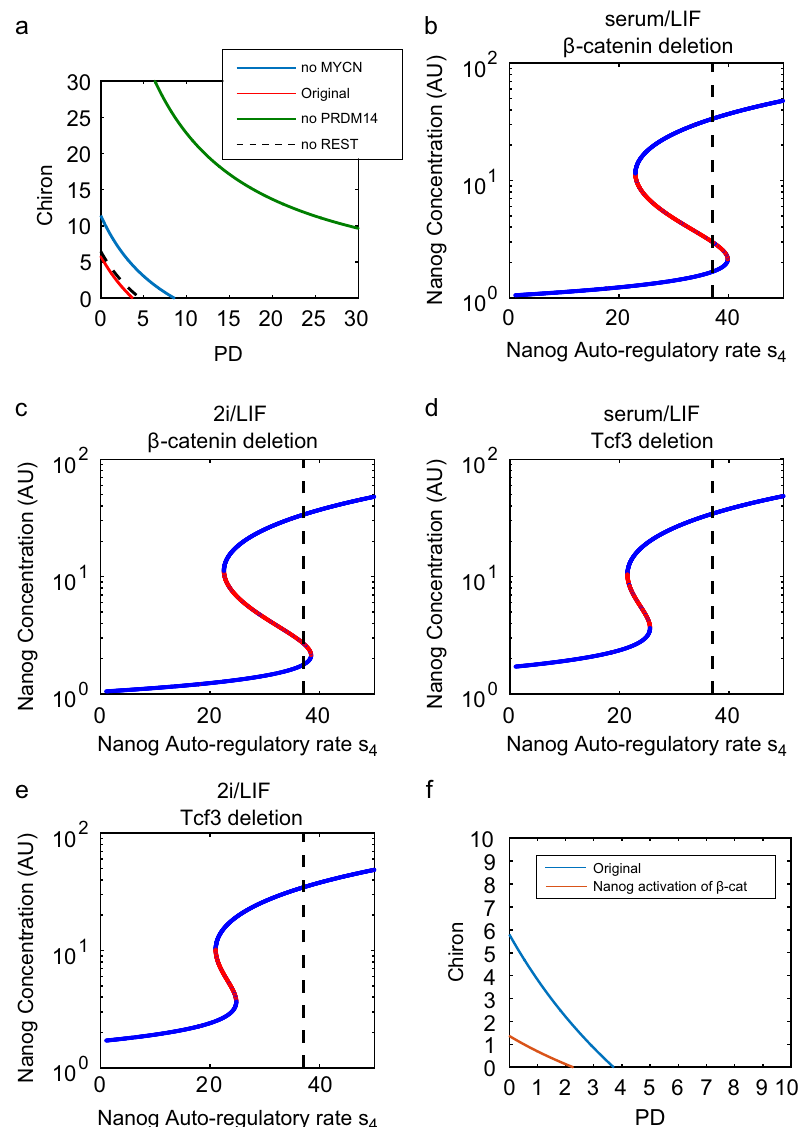
Fig. 4 Bifurcation analysis of the full system, and upon single network factor deletion a Two-parameter continuation (PD and Chiron). The area above each curve denotes the parameter (i.e., PD and Chiron) region in which the deterministic system exhibits monostability (NH only) for the full network ( red line ), and upon single deletion of Rest ( dashed line ), Mycn ( blue line ), and PRDM14 ( green line ). The graph shows that both PD and Chiron, with varying levels depending on gene deletion, are required to enter the monostable region. b – e Continuation of Nanog steady-state for the deterministic system, varying maximal transcription rate s 4 , upon β -catenin deletion in serum/LIF ( b ) and 2i/LIF ( c ), and upon Tcf3 deletion in serum/LIF ( d ) and 2i/LIF ( e ). Blue lines are stable steady-states, while the red lines are unstable. f Two-parameter continuation (PD and Chiron). The area above the curve denotes the values of PD and Chiron in which the deterministic system exhibits monostability (NH only) for the full network, including an activation of Nanog on β -catenin ( red line ) comparing to the original full network with no additional activation of β -catenin ( blue line